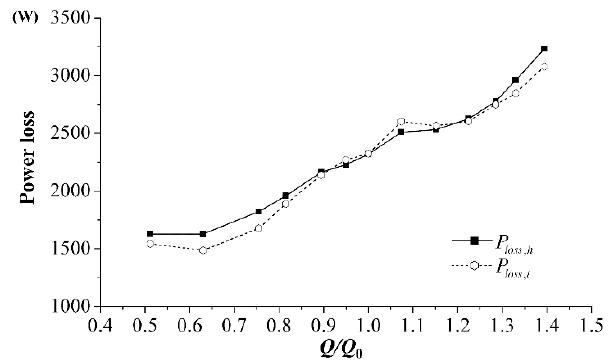
Figure 8. Influence of the discharge on both the internal and hydraulic power losses.